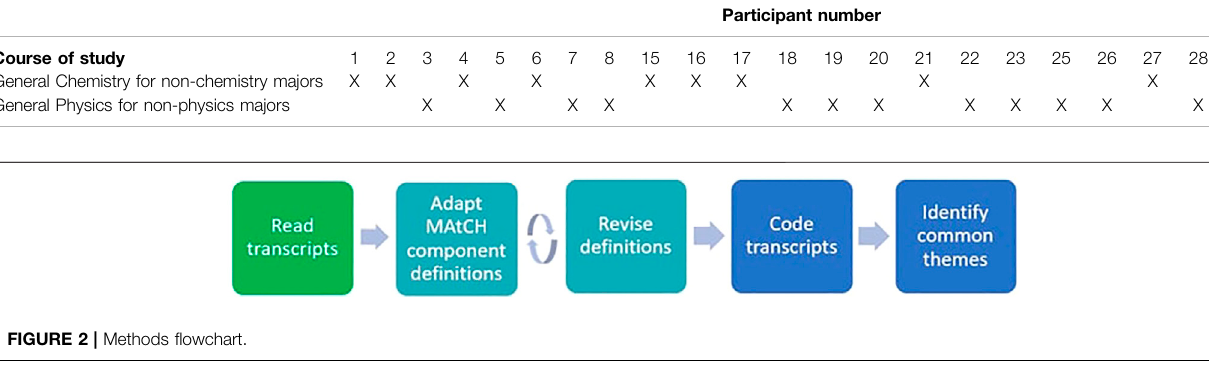
FIGURE 2 | Methods fl owchart.